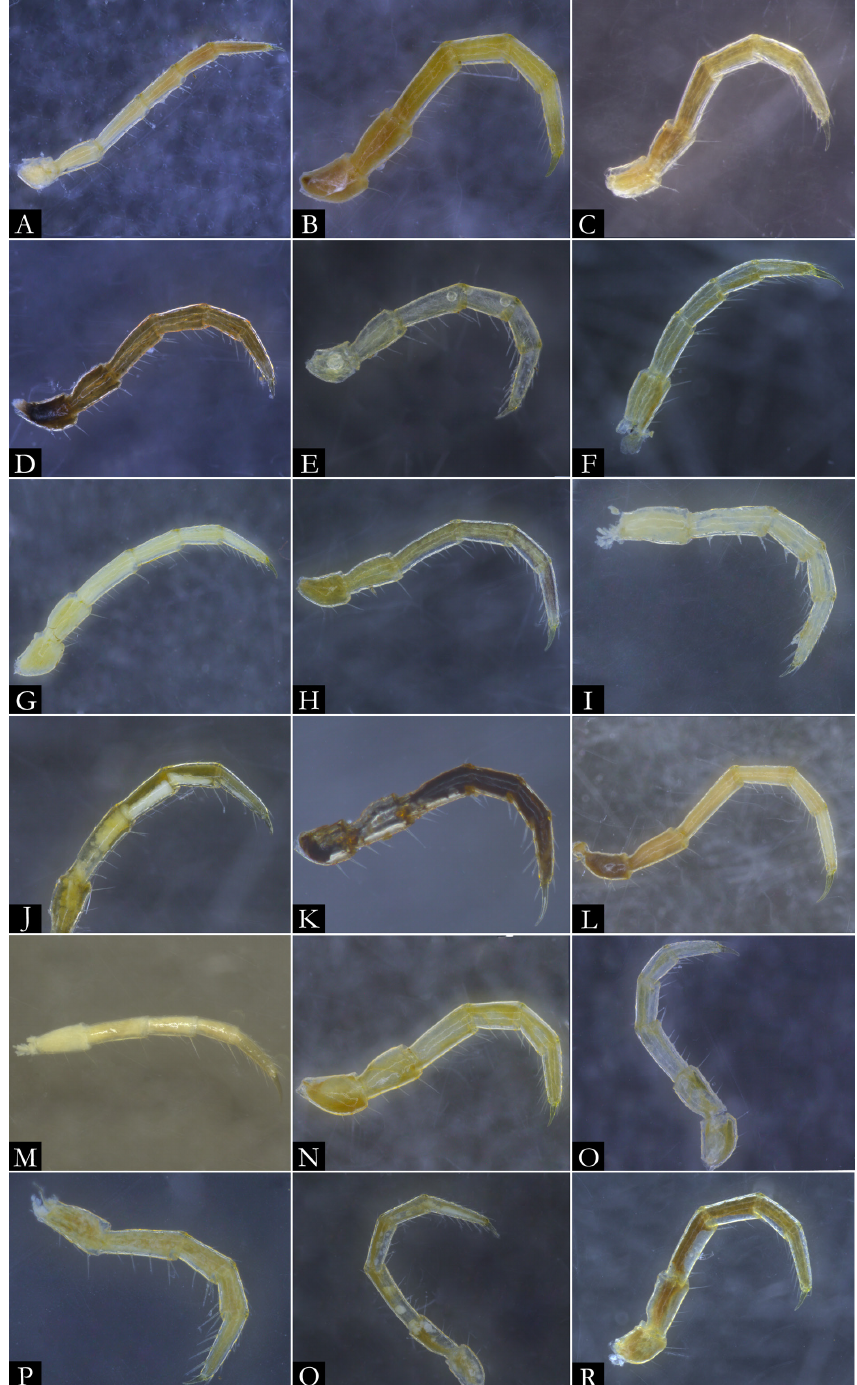
Fig. 166. Stereoscopic images of midbody legs of species of Pseudonannolene Silvestri,